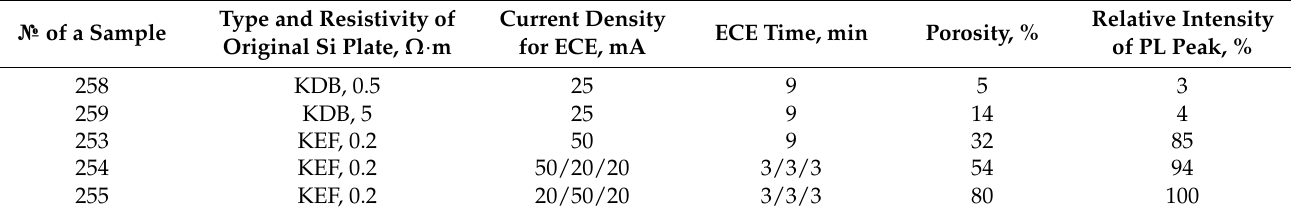
Table 1. Fabrication parameters for obtaining porous silicon samples and the results of the study of porosity and